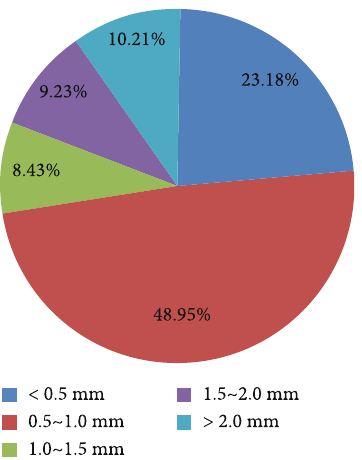
Figure 8: Fan chart of bedding fracture aperture distribution of Lucaogou formation in Jimsar